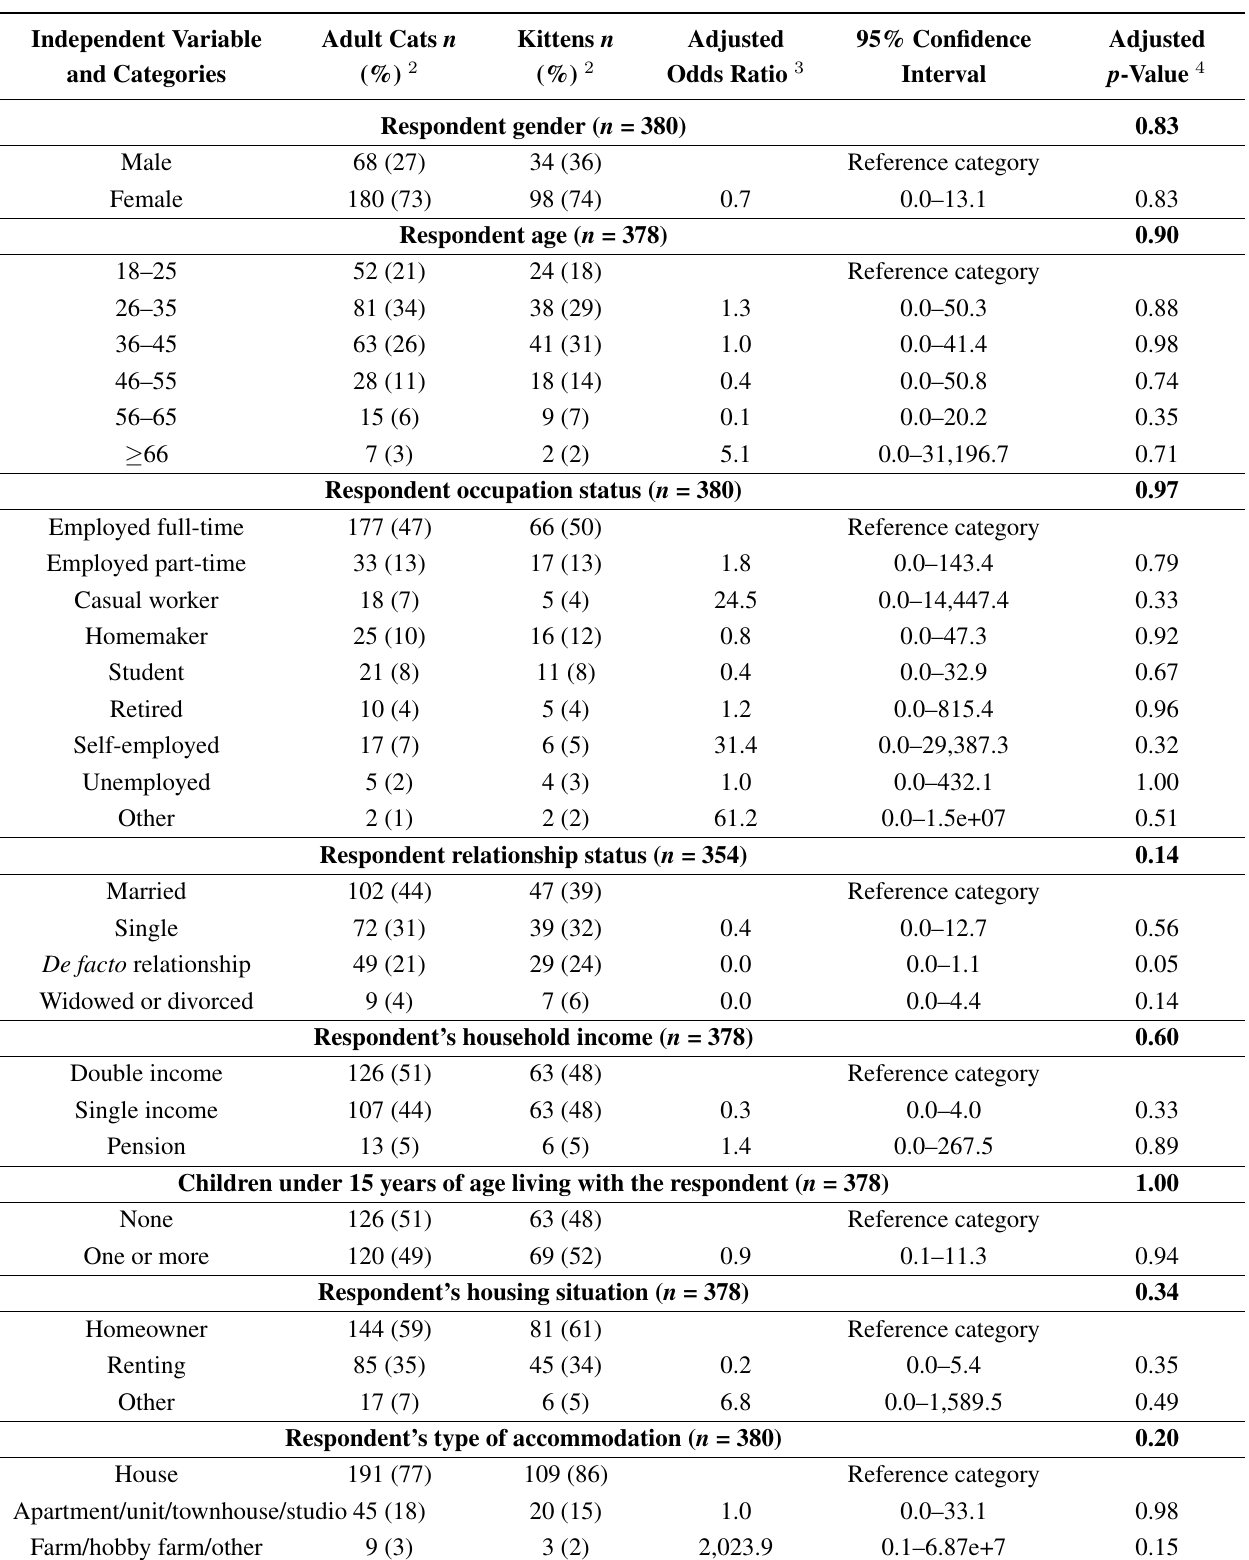
Table S2. Distributions of cats by cat age group (adult cat or kitten) and associations between potential determinants of cat age group adopted for 389 cats adopted from an animal shelter in Australia in 2013 (for those variables which had a p -value ≥ 0.1 on initial univariable screening